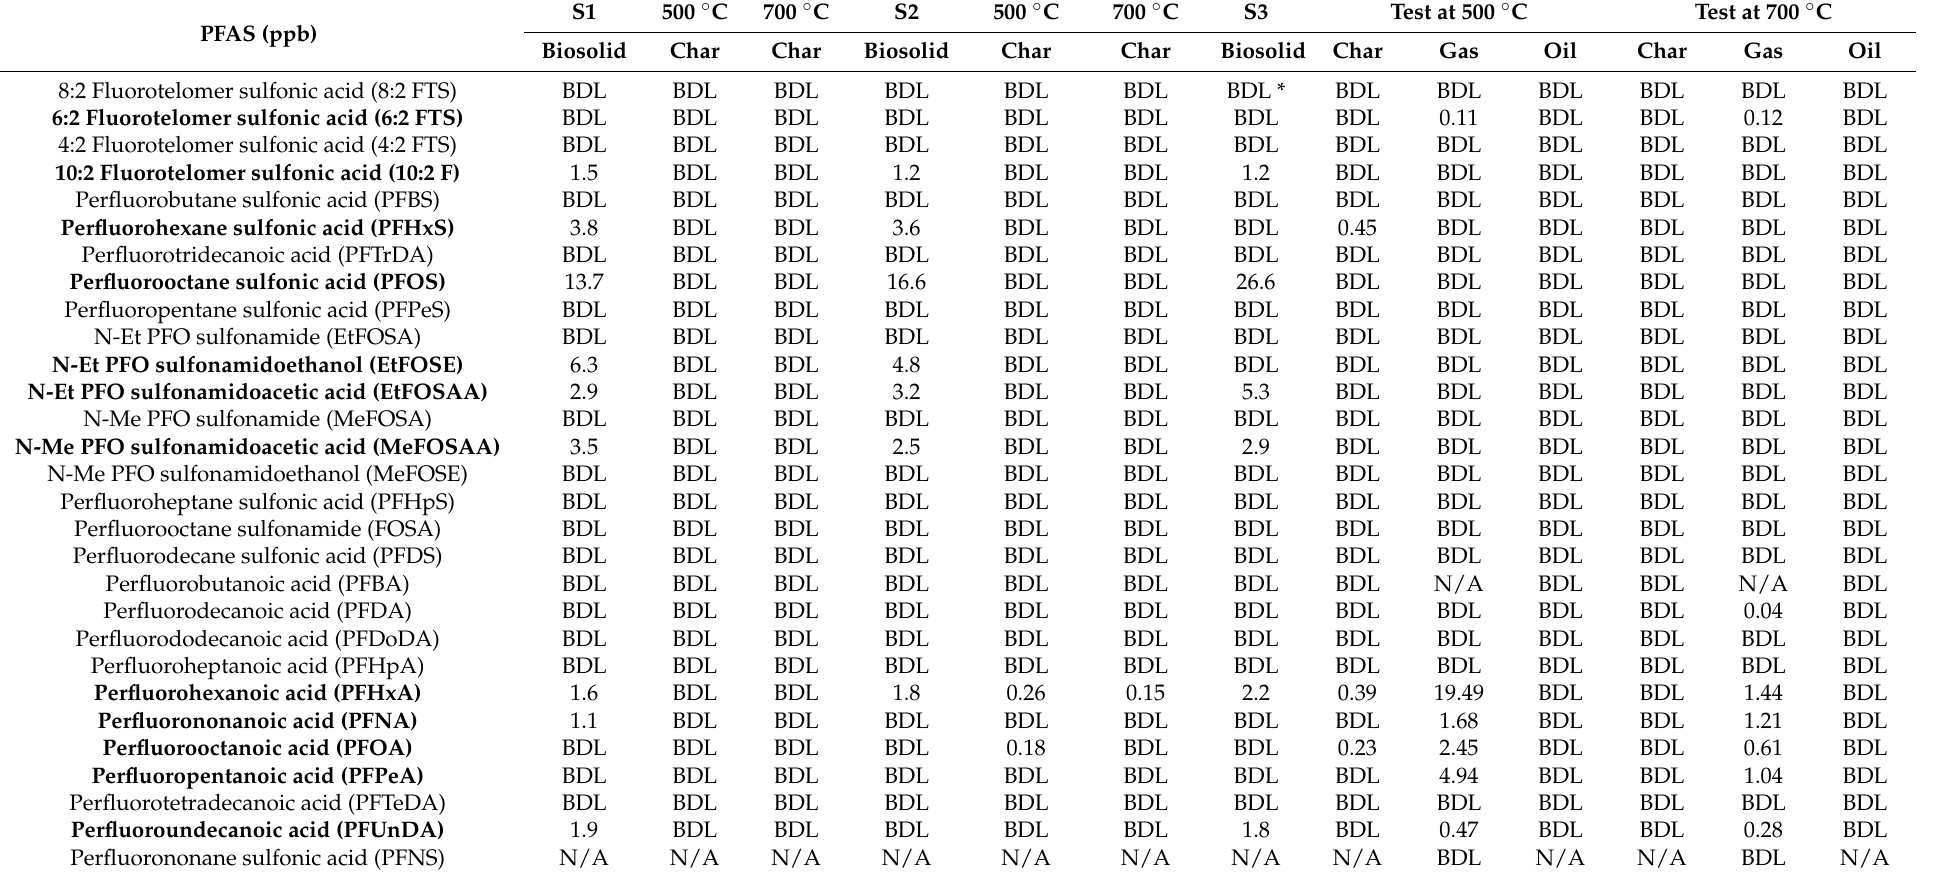
Test at 500 ◦ C Test at 700 ◦ C